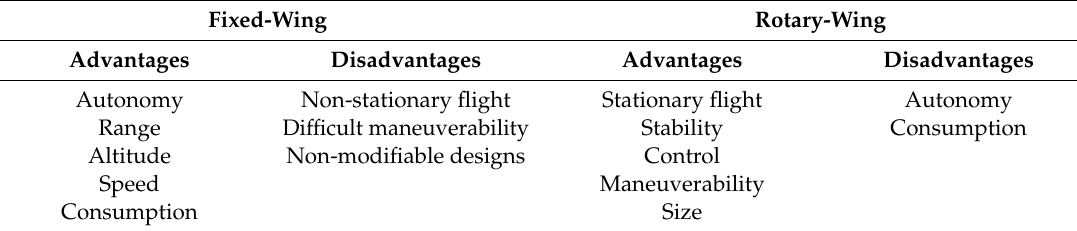
Table 3. Advantages and disadvantages of fixed- and rotary-wing aircraft.